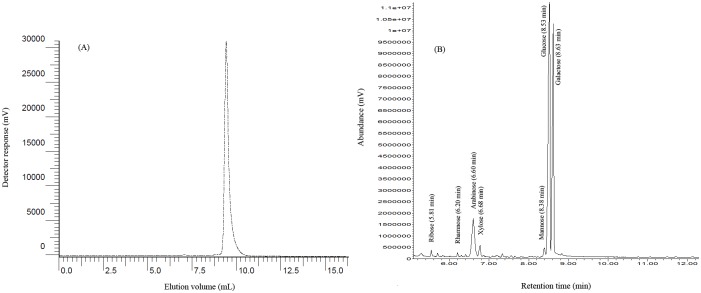
Homogeneity and Mw of the EPS by SEC analysis (A) and composition of the EPS by GC analysis (B).